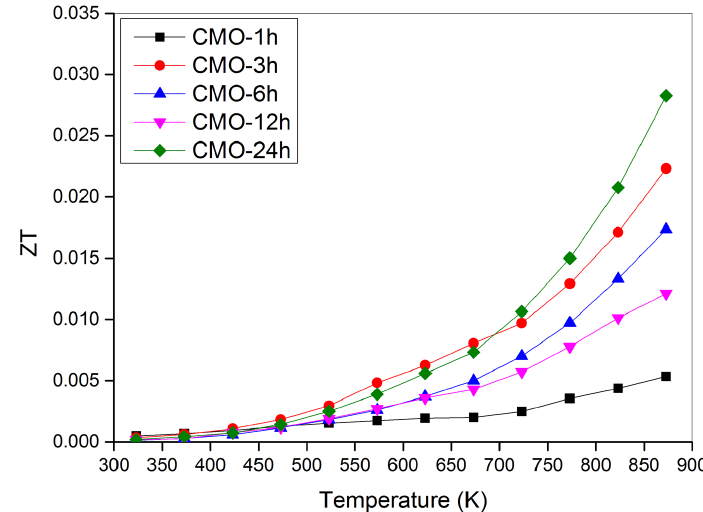
Figure 7. ZT values of the CMO